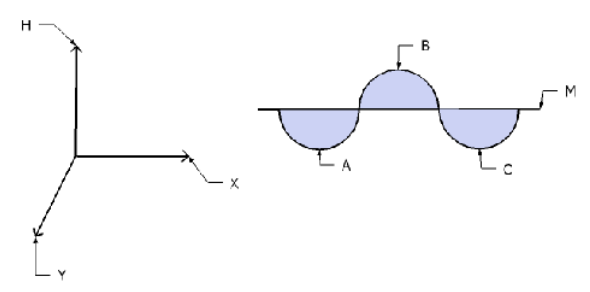
Figure 2. A wave peak and its neighbour low points in a 2-D view and the arbitrary local Cartesian coordinate